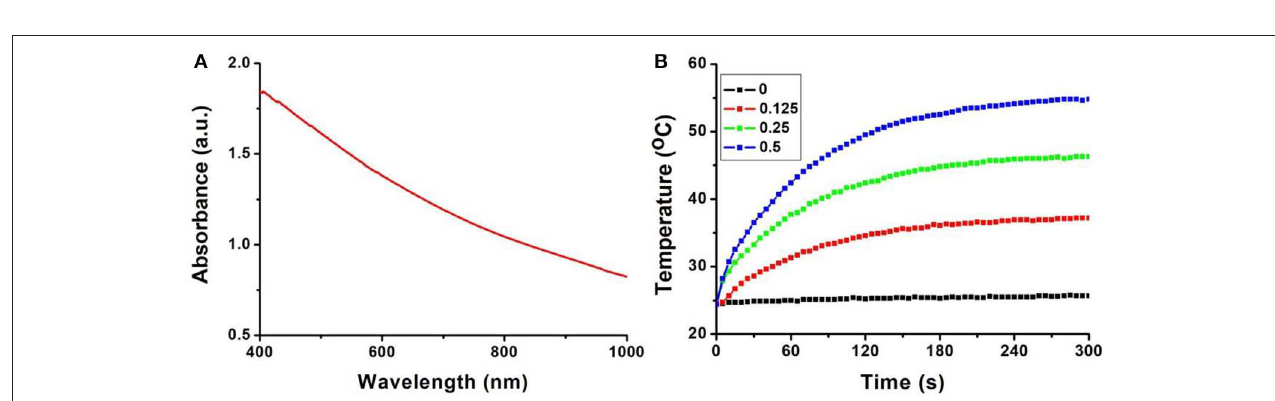
FIGURE 3 | (A) UV-vis absorbance spectrum of the Fe 3 S 4 nanoparticles. (B) Temperature change of the Fe 3 S 4 nanoparticles in water at varied concentrations (i.e., 0, 0.125, 0.25, and 0.5 mg/mL) as a function of the irradiation time of an 808nm laser (0.33W cm − 2